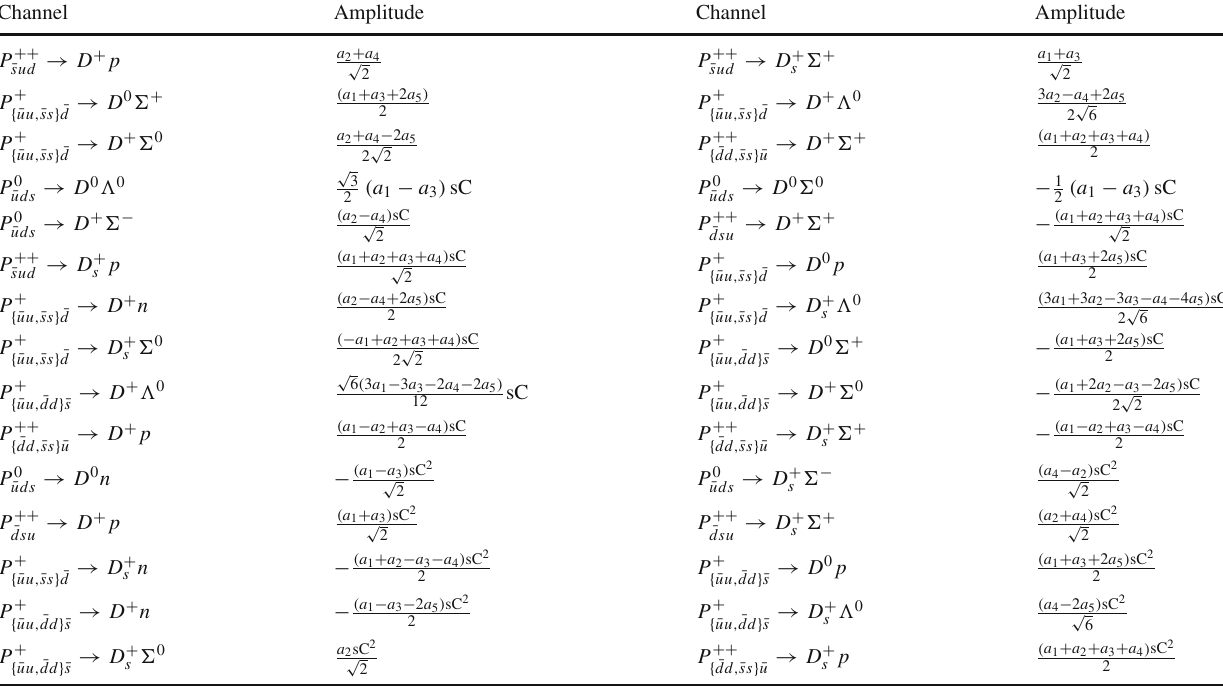
Table 4 Pentaquark P 6 ( cc ¯ qqq ) decays into charmed mesons and octet light baryons with the Cabibbo allowed, singly Cabibbo suppressed and doubly Cabibbo suppressed. sC represents the overall CKM factor sin (θ C ) Channel Amplitude Channel Amplitude → D + p a 2 + a 4 √ P ++ ¯ sud